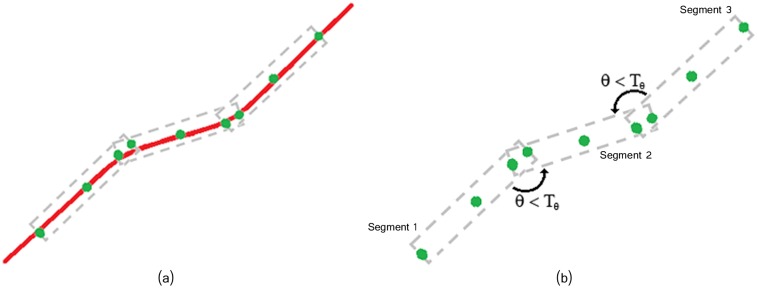
Fixed length segments are merged if they overlap and their angle difference is not too large θ < Tθ.(a) Filament partitioned into fixed-length segments. (b) Overlapping and angle difference between segments.